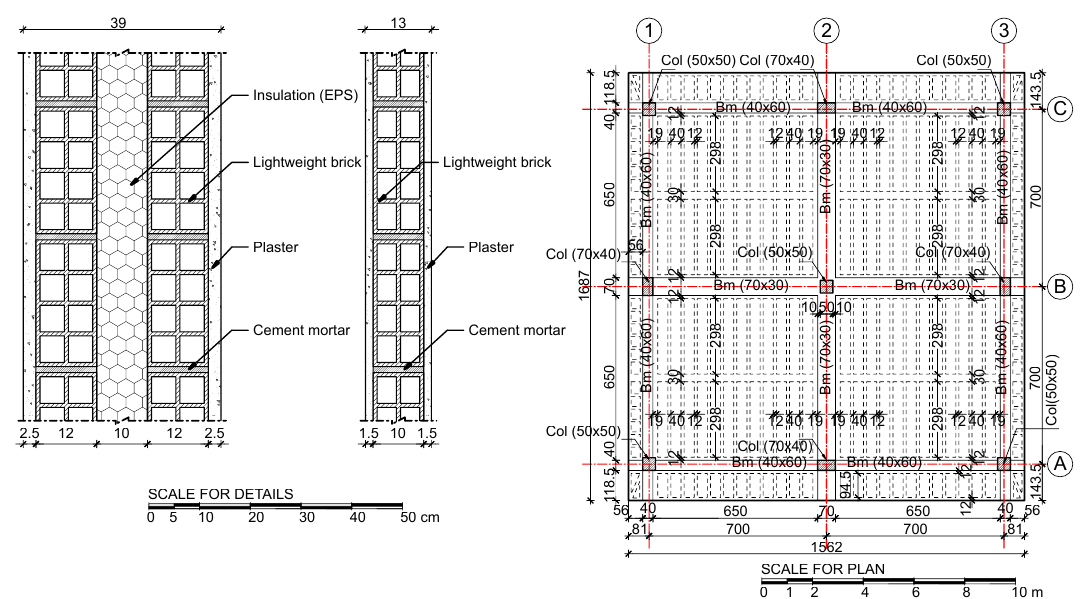
Figure 9. Cast-in-situ structure: cross section of internal and external wallboards and structural